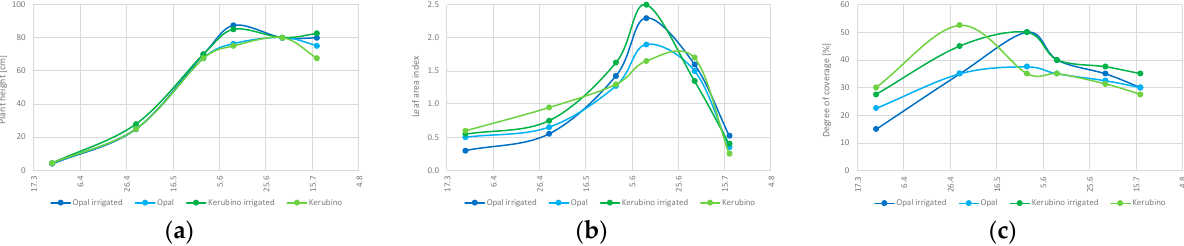
Figure 9 . Modeled and measured soil moisture [% AWC] of unirrigated winter wheat plots Opal and Kerubino and pre ‐ cipitation [mm] in the period March to July 2015.